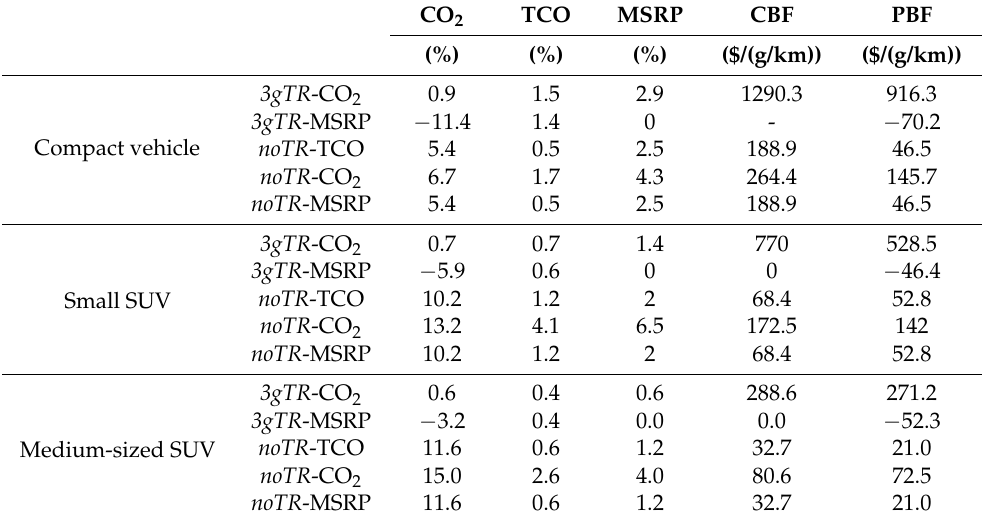
Table 10. Reduction in CO 2 emissions (1st column), increment in TCO (2nd column) and MSRP (3rd column), CBF (4th column) and PBF (5th column) of the five designs for the three segments, with respect to x 3 gTR ,TCO